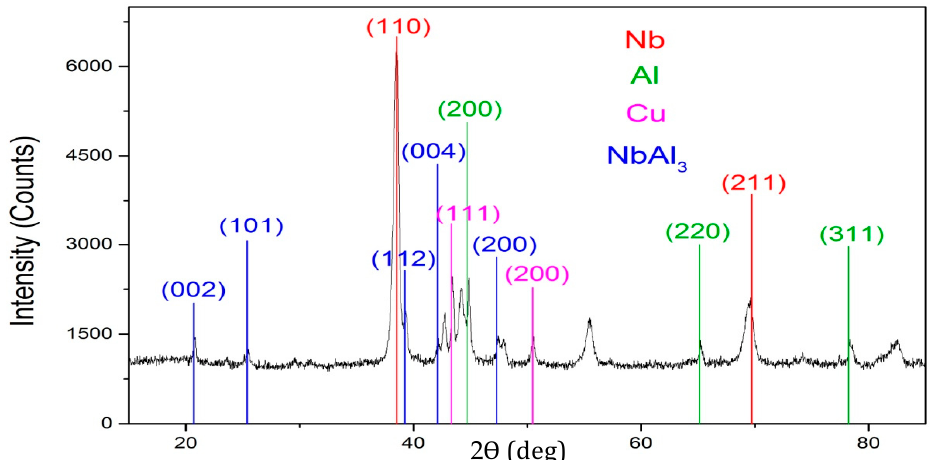
Figure 5. The X-ray diffraction for 2.60 km/s specimen.